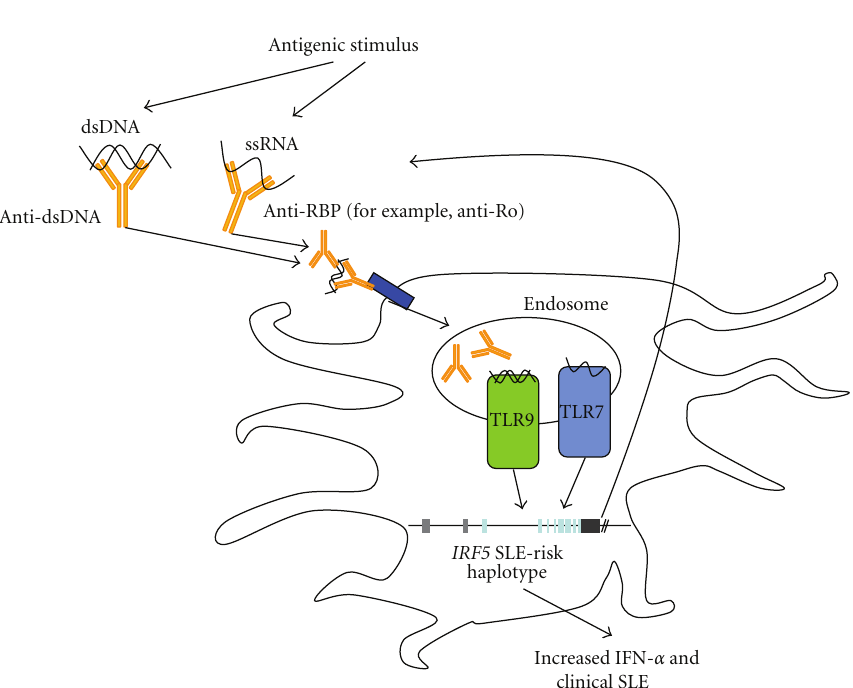
Figure 3: Diagram showing relationships between SLE-associated autoantibodies, IRF5 genotype and IFN- α involved in the pathogenesis of SLE [64]. This suggests a “feed-forward” model in which specific auto-antibodies interact with particular IRF5 risk variants which also predispose to the same antibody formation.